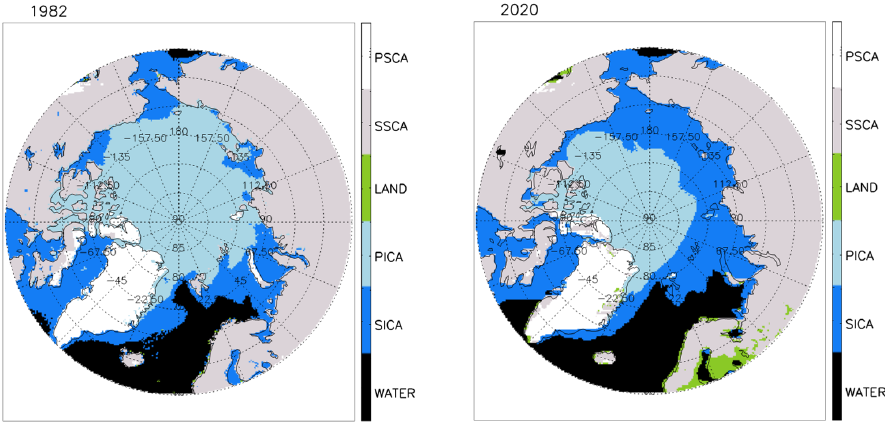
Figure 1. Spatial distribution of Arctic sea ice extent in 1982 ( left ) and 2020 ( right ) derived from NOAA/NSIDC Climate Data Record of Passive Microwave Sea Ice Concentration. Color bar notation: WATER means open water area, SICA stands for seasonal ice-covered area, PICA denotes perennial ice-covered area, LAND means snow-free land, SSCA stands for seasonal snow covered land area, and PSCA denotes perennial snow covered land area.